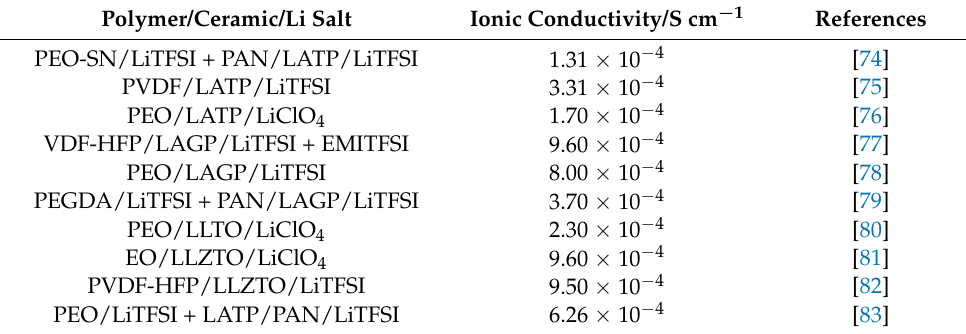
Table 3. Composite electrolytes and their ionic conductivity for the application in